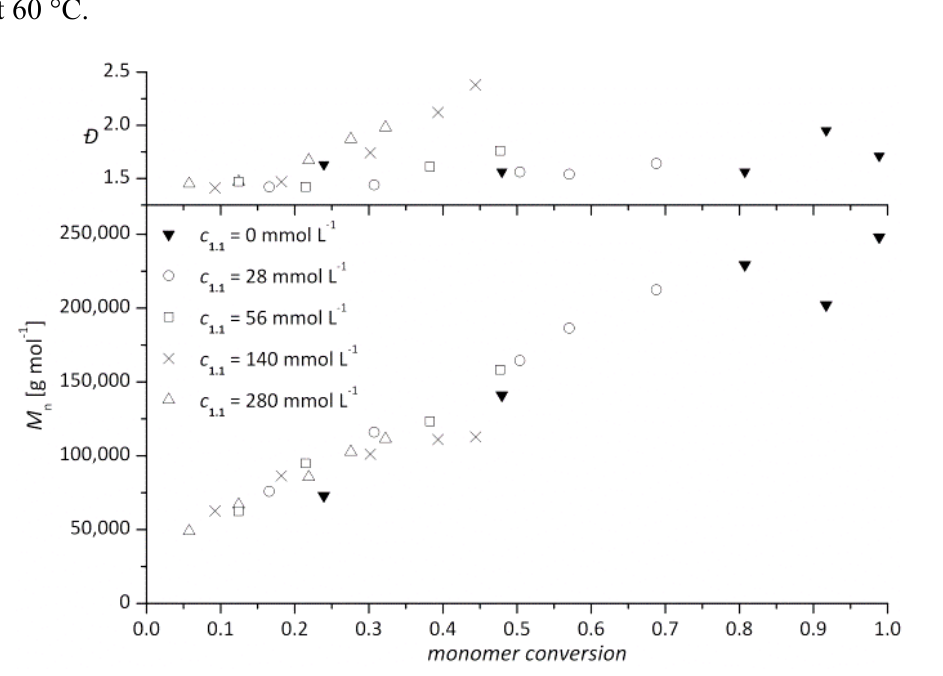
, and dispersity, Đ , with n 3 and 1.1 mmol·L − 1 AIBN in 6